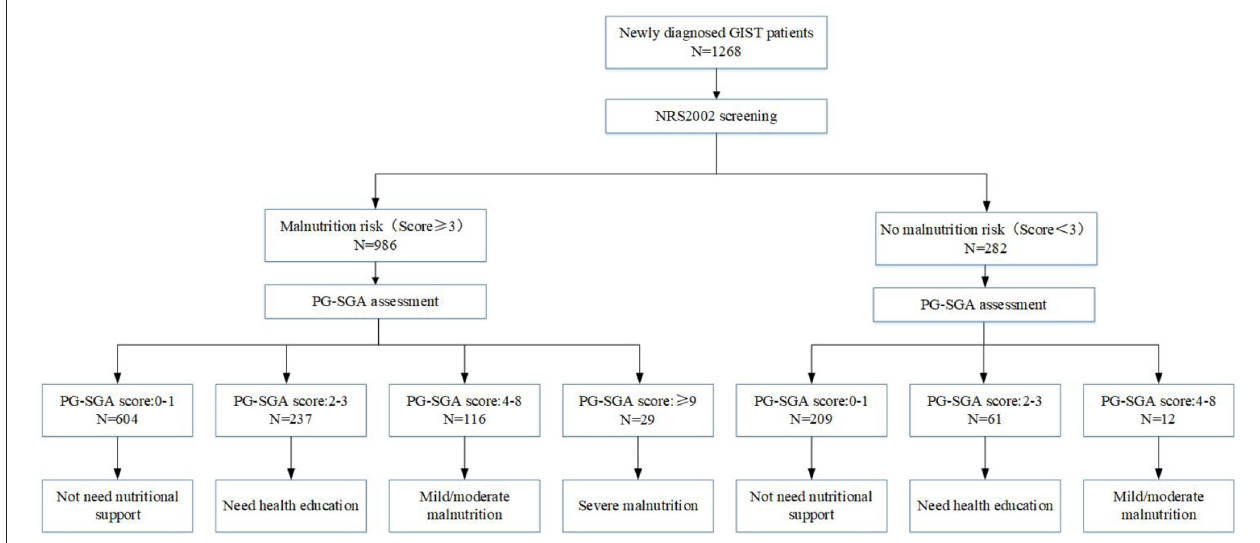
FIGURE 1 | Nutrition screening and assessment of 1,268 newly diagnosed GIST patients.